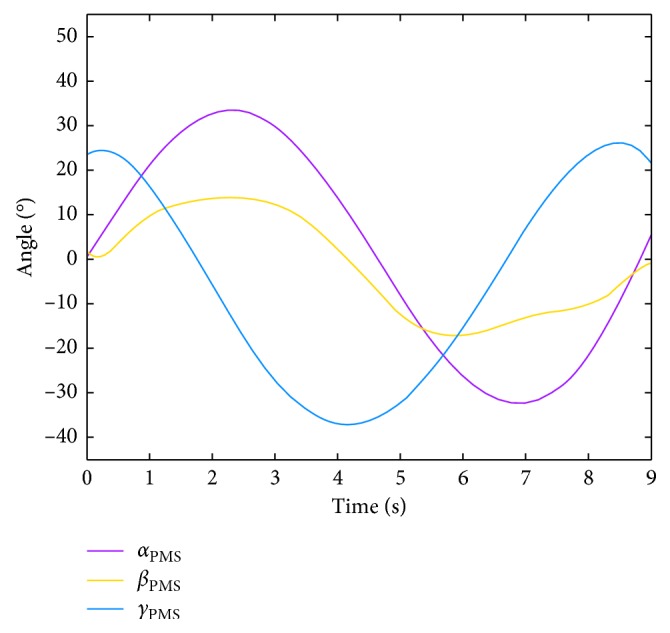
Attitude angles in the boundary elliptical motion.